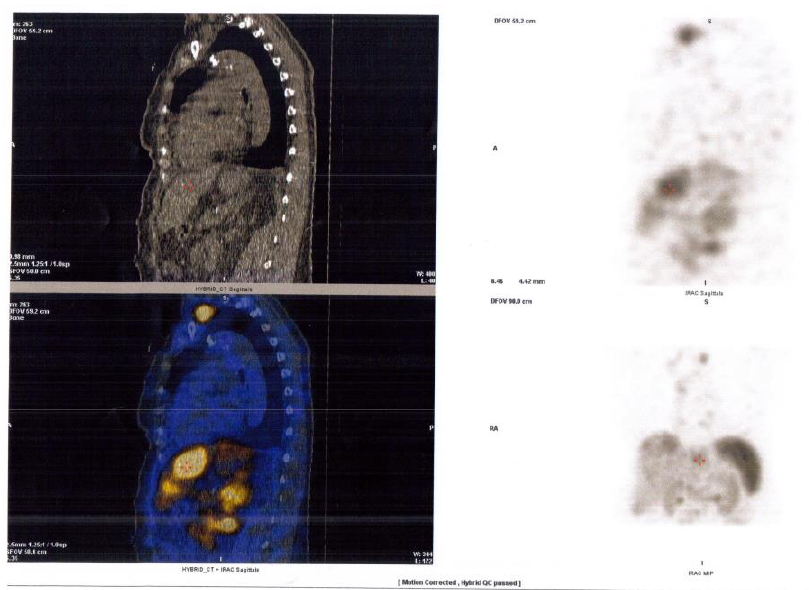
Figure 6. 99mTc-Tektrotyd scintigraphy and SPECT-CT showing multiple metastases in the supra-